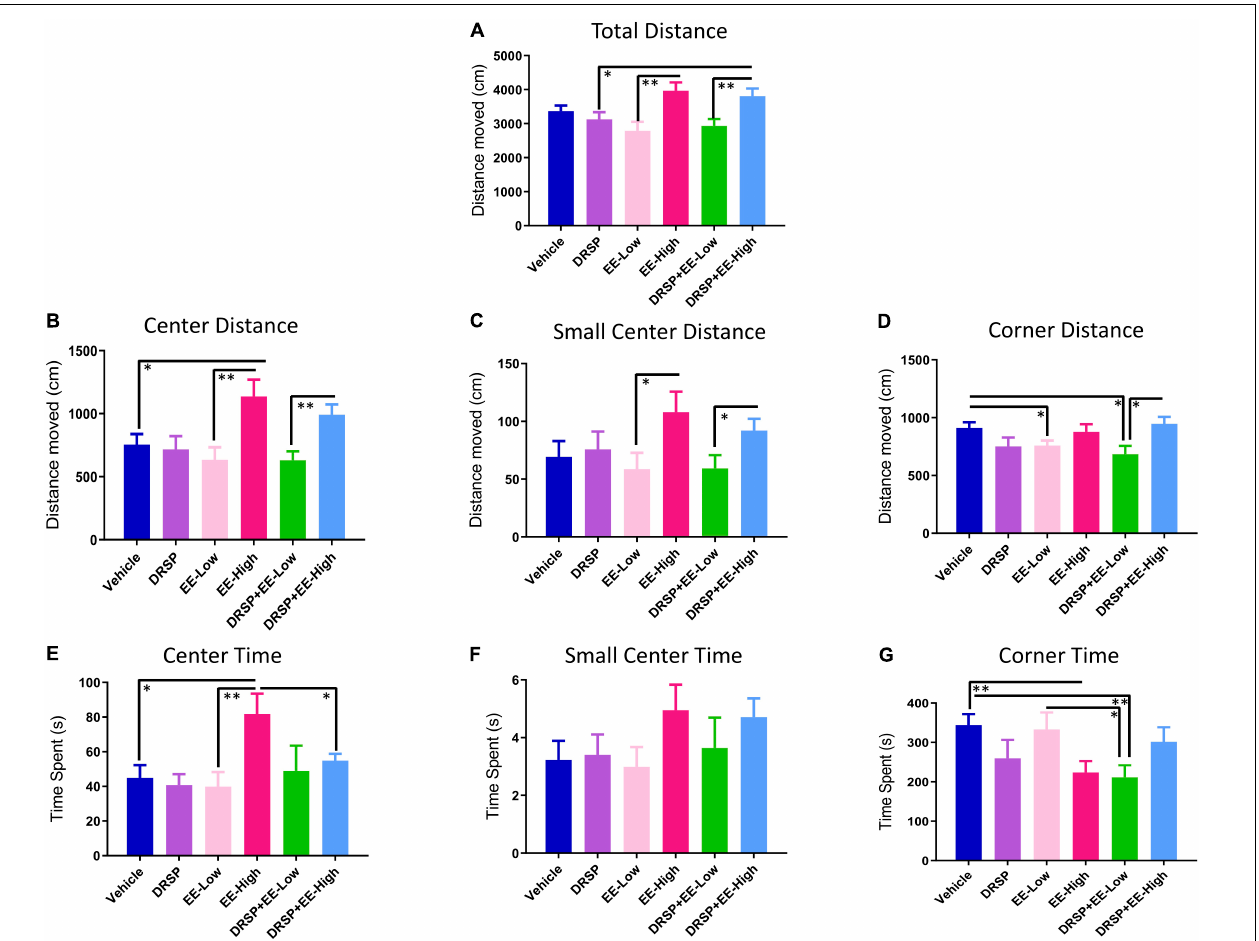
FIGURE 6 | Experiment 2 Open field task performance. Performance varied across: (A) Total Distance Moved, (B) Center Distance, (C) Small Center Distance, (D) Corner Distance, (E) Center Time, (F) Small Center Time, and (G) Corner Time, in the OFT. In general, the EE-High group exhibited decreased anxiety-like behavior in the Open Field. ∗ p < 0.05 and ∗∗ p < 0.01. Vehicle n = 10, DRSP n = 10, EE-Low n = 10, EE-High n = 10, DRSP + EE-Low n = 10, and DRSP + EE-High n =